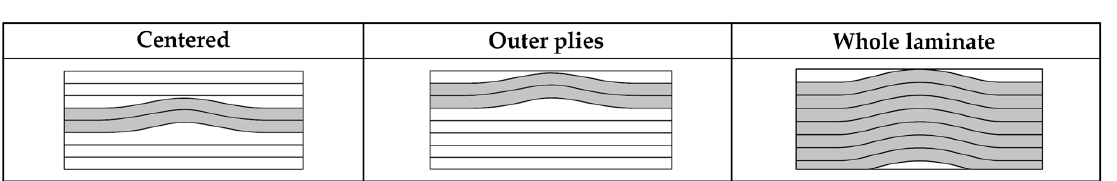
Figure 34. Portion and position of the wavy layers in the laminate.